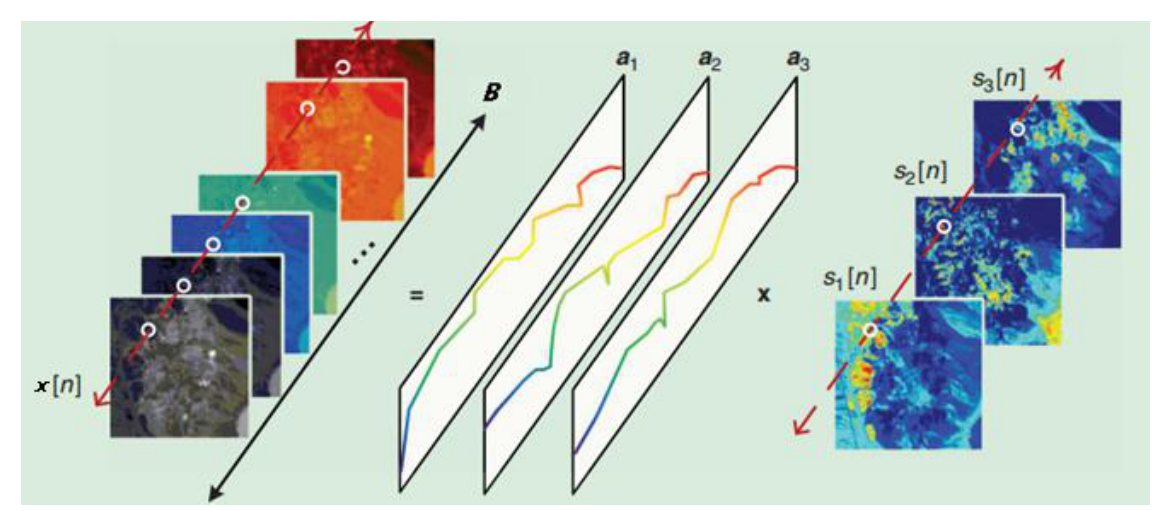
Figure 1. The linear mixing model of hyperspectral images